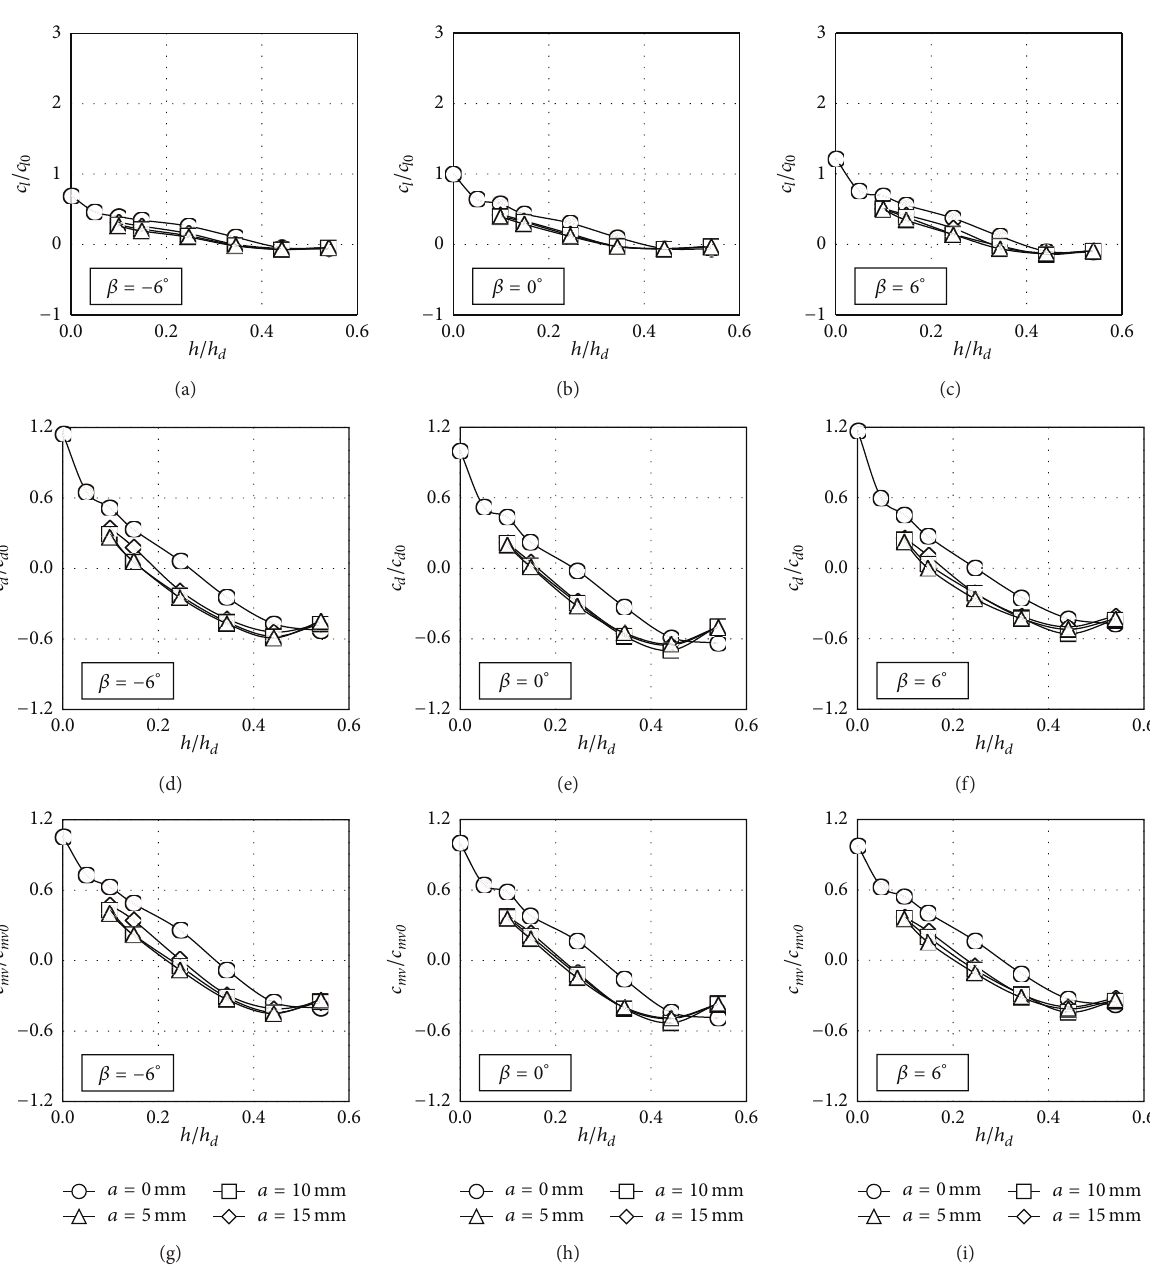
Figure 14: Lift, 𝑐 𝑙 /𝑐 𝑙0 , side force, 𝑐 𝑑 /𝑐 𝑑0 , and rolling moment, 𝑐 𝑚 V /𝑐 𝑚 V 0 , coefficient ratios as a function of the windbreak height, when the train coach is placed on the leeward rail on the embankment with slope 1: 1. Four eave lengths are considered, 𝑎 = 0 mm (circles), 𝑎 = 5 mm (rhombi), 𝑎 = 10 mm (squares), and 𝑎 = 15 mm (triangles). Each column represents a different coach rolling angle, 𝛽 = −6 ∘ (left), 𝛽 = 0 ∘ (centre), and 𝛽 = 6 ∘